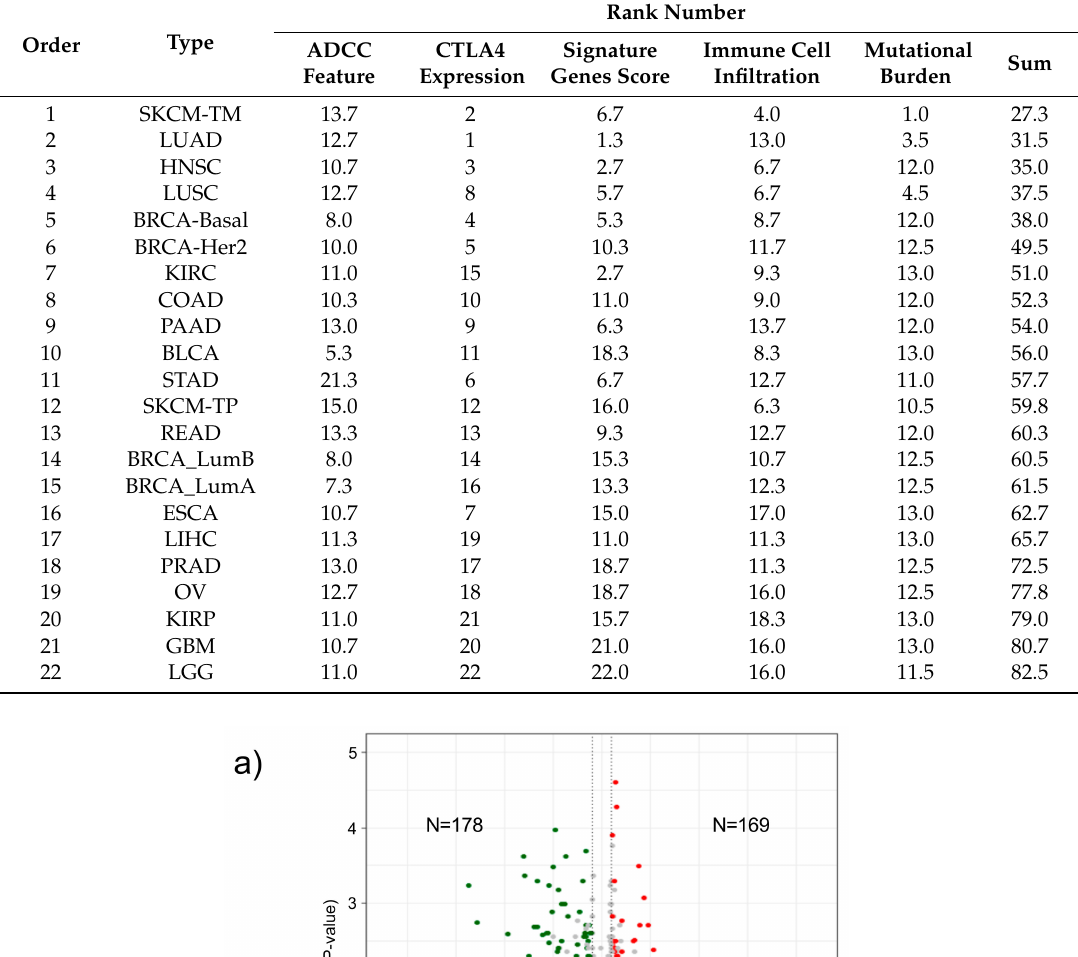
Table 1. Ranking human cancer for their responsiveness to anti-CTLA-4 therapy.